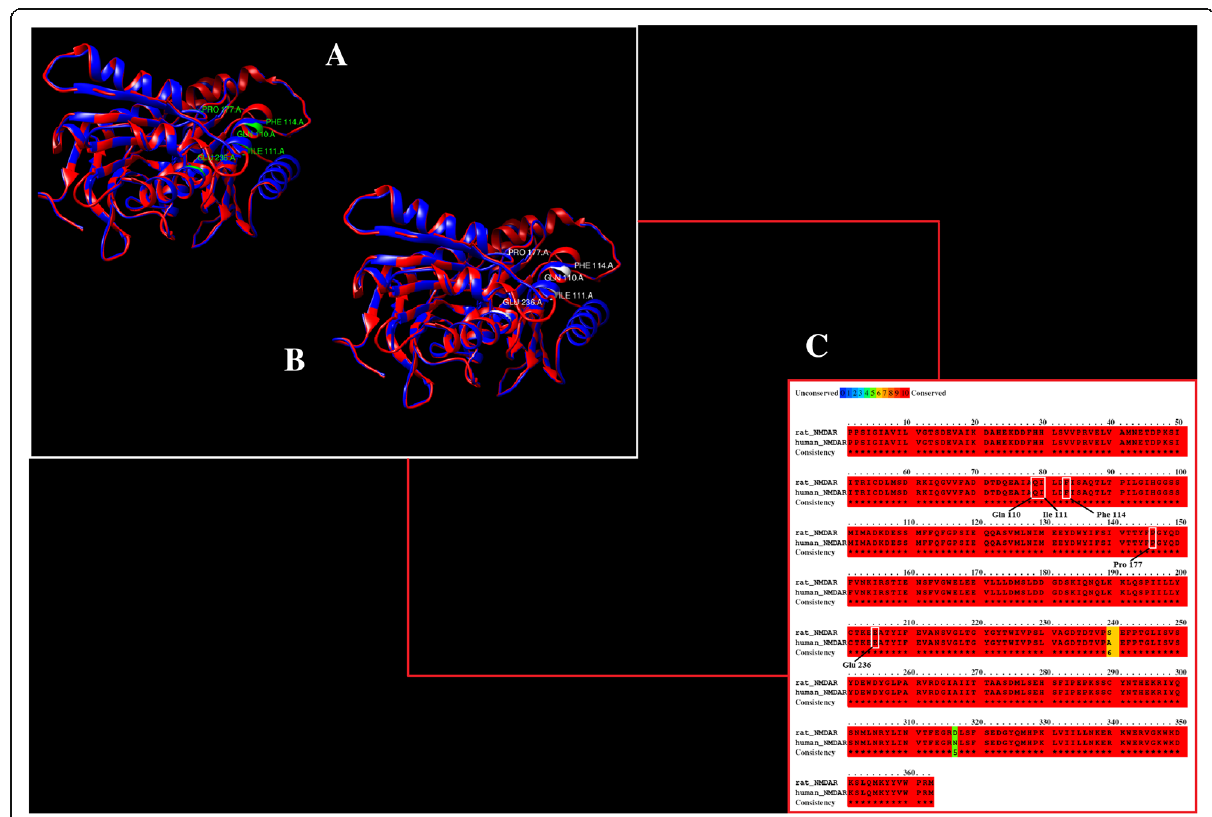
Fig. 3 a NMDAR in humans (red) active residues highlighted in green. b NMDAR in rats (blue) residues aligned with residues of NMDAR in humans highlighted in white. c Conserved residues shown in sequence alignment between the NMDA receptor in rats (above) and humans